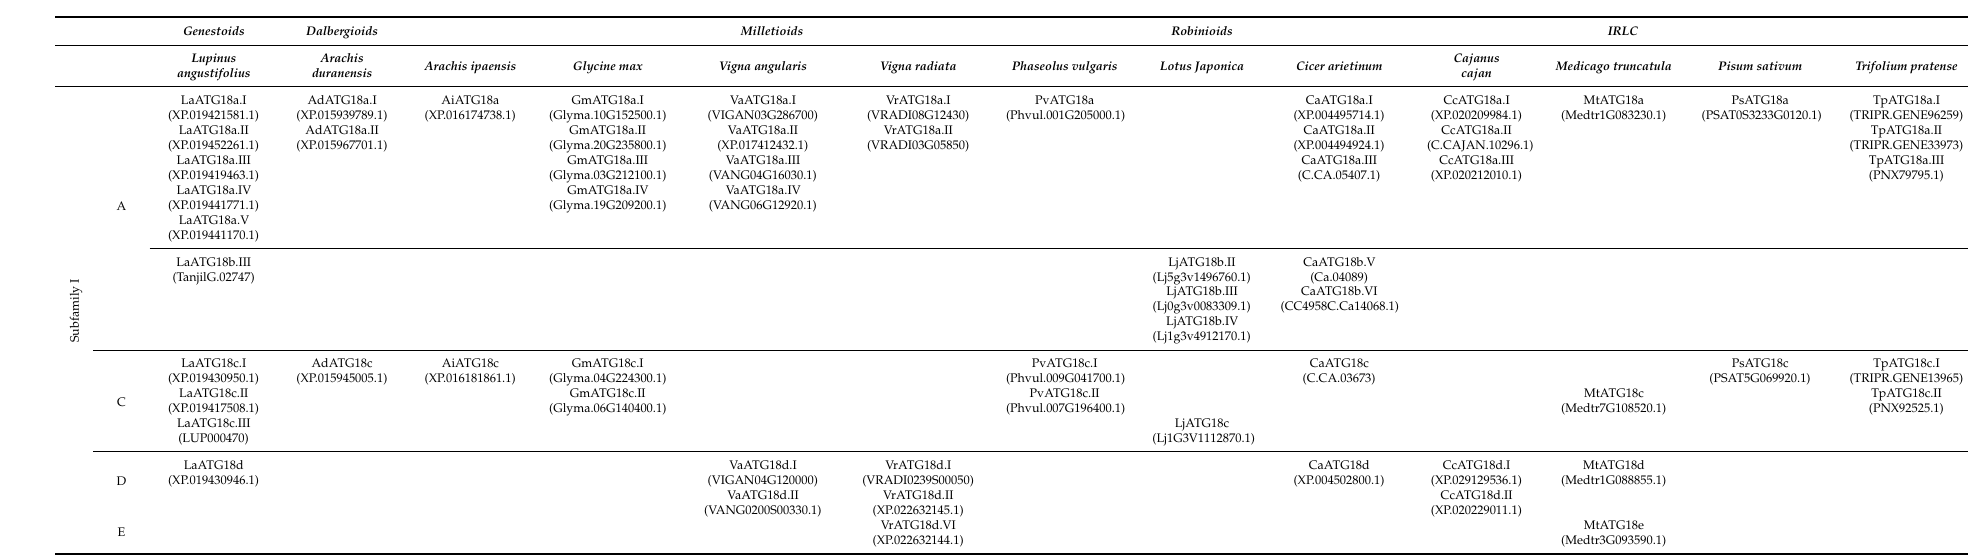
Table 3. List of ATG18 homologs in